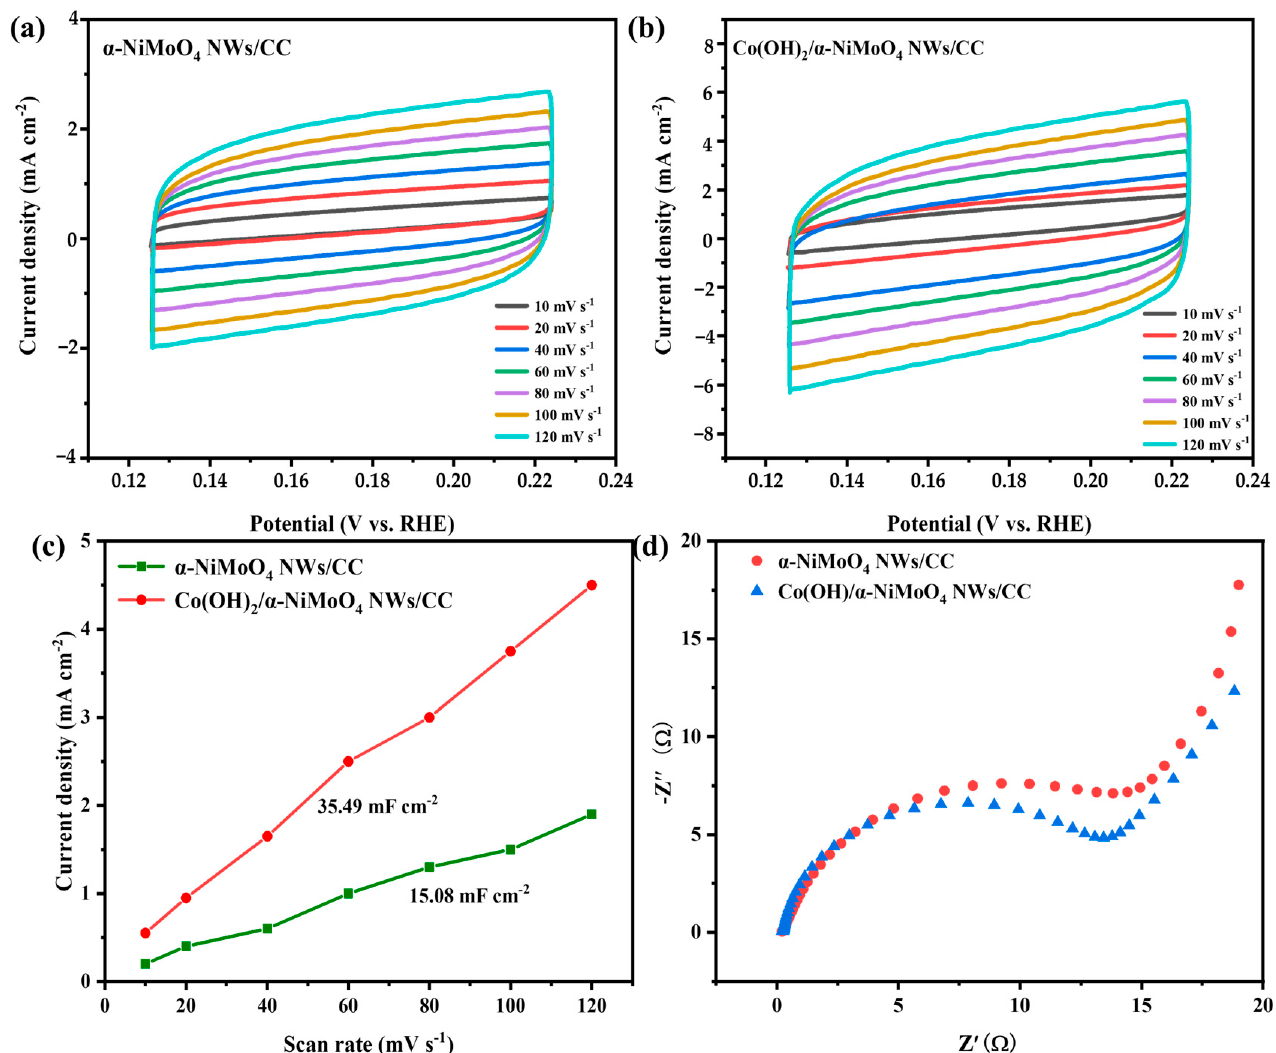
Figure 4. ( a ) CV of α‐ NiMoO 4 NWs/CC catalyst at different sweep rates; ( b ) CV of Co(OH) 2 / α‐ NiMoO 4 NWs/CC catalyst at different sweep rates; ( c ) function of capacitance current and scanning rate and ( d ) EIS of α‐ NiMoO 4 NWs/CC and Co(OH) 2 / α‐ NiMoO 4 NWs/CC.